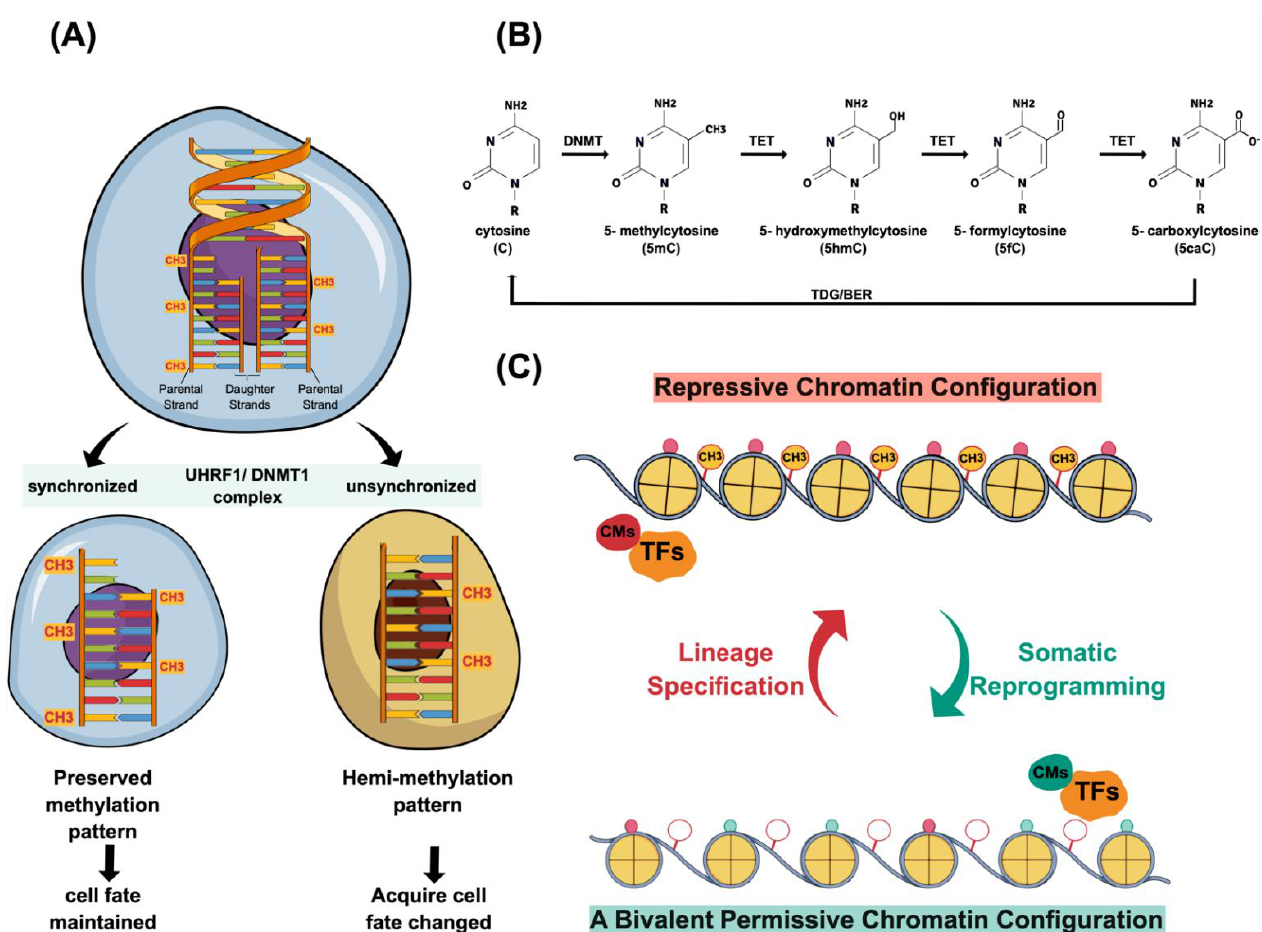
Figure 2. Diverse mechanisms coordinate genome plasticity. ( A ) The replication-mediated passive DNA demethylation process results in cell fate change. The newly replicated strands do not share the same methylation pattern as seen in their parental DNA molecule. To faithfully maintain the methylation pattern, the complex of UHRF1/DNMT1 is recruited to perform the de novo methyl-transfer activity on the newly synthesized strands. This uncoupled methyl-transfer reaction from DNA replication offers an opportunity to diversify the cell fate. In the scenario of an unsynchronized event, the unmethylated daughter strand creating a hemimethylated pattern may allow its underlying regulatory elements to be susceptible to the signal inputs from the surrounding environment. Therefore, cell division event creates two daughter cells bearing different cell states, which is feasible for diversifying cell fates. ( B ) The Tet-mediated active DNA demethylation mechanism. Tet1, Tet2, and Tet3 belong to the Tet family of DNA demethylase. These Tets catalyze 5- hydroxymethylcytosine (5mC) through a series of oxidation processes, and generate a set of intermediated products, including 5-hydroxymethylcytosine (5hmC), 5-formylcytosine (5fC), and 5-carboxylcytosine (5caC). Furthermore, the thymine DNA glycosylase (TDG) mediates the excision of 5fc and 5caC. Eventually, the base excision repair (BER) mechanism restores the cytosine nucleotide in the demethylation process. ( C ) Chromatin-mediated cell fate change. In addition to the DNA methylation pattern impacting the epigenetic configuration, chromatin modifications also play a pivotal role in regulating the epigenetic landscape. A two-way relationship between transcription factor binding and chromatin structure modification further shapes its epigenetic landscape. Hence, the transcriptional network, chromatin structure, and DNA methylation pattern work together to establish a unique state of epigenomic configuration representing an individual cell fate. TFs—transcription factors; CMs—chromatin